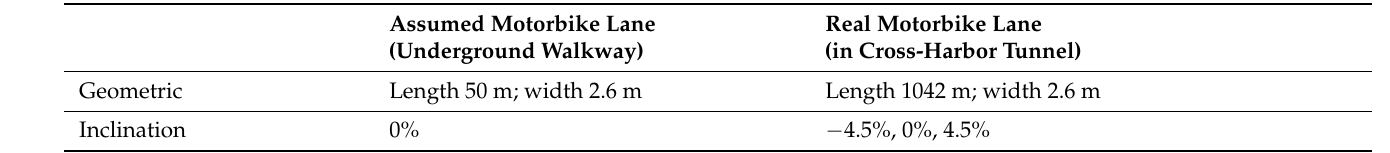
Table 3. Differential analysis of assumed motorbike lane and real motorbike lane in Cross- Harbor